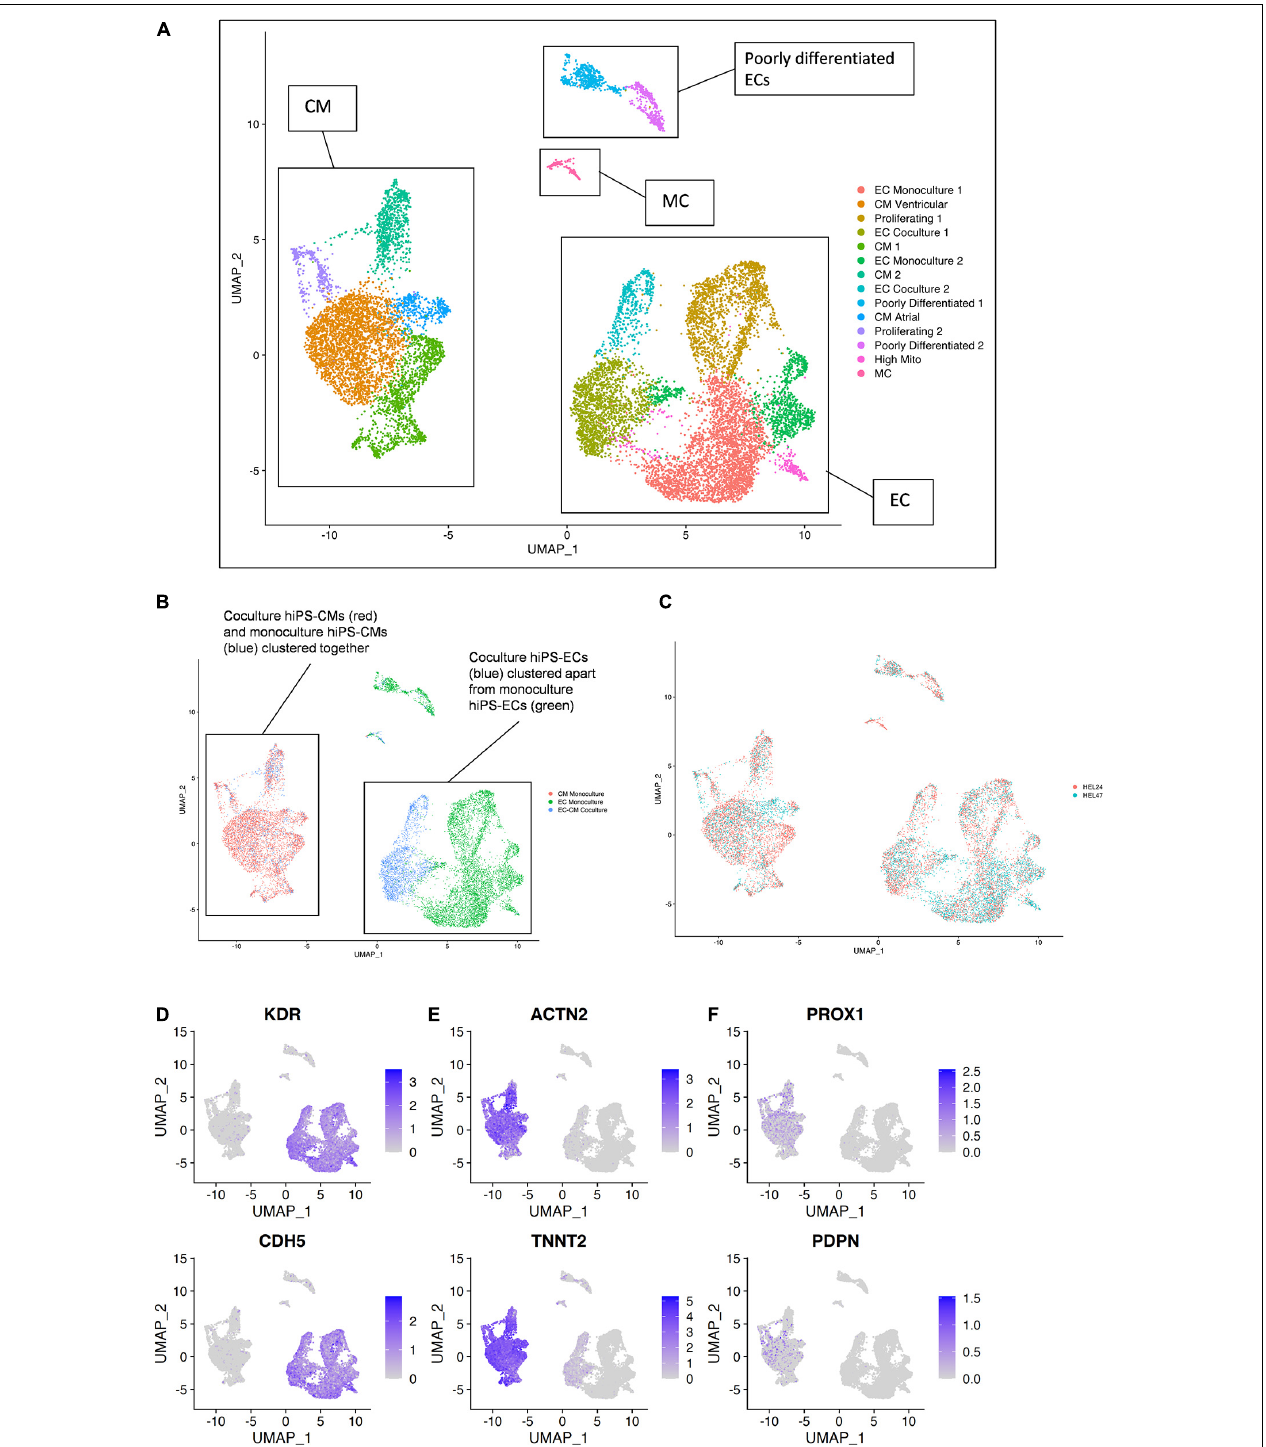
FIGURE 3 | Single-cell transcriptome of six combined samples [(1) HEL24.3 hiPS-EC monoculture, (2) HEL24.3 hiPS-CM monoculture, (3) HEL24.3 co-culture of hiPS-CMs and hiPS-ECs, (4) HEL47.2 hiPS-EC monoculture, (5) HEL24.3 hiPS-CM monoculture, and (6) HEL47.2 co-culture of hiPS-CMs and hiPS-ECs]. (A) Uniform Manifold Approximation and Projection (UMAP) plot of delineated clusters. Endothelial cells (EC), cardiomyocytes (CM), mesenchymal cells (MC), and poorly differentiated ECs have been highlighted. (B) The same UMAP plot according to cell culture conditions [(1) hiPS-EC monoculture (green), (2) hiPS-CM monoculture (red), and (3) hiPS-EC/hiPS-CM co-culture (blue)]. (C) The same UMAP plot according to cell line (1) HEL24.3 (salmon), and (2) HEL47.2 (skyblue). Feature plots on the expression of (D) vascular endothelial markers (E) cardiomyocyte markers (F) lymphatic endothelial cell markers.